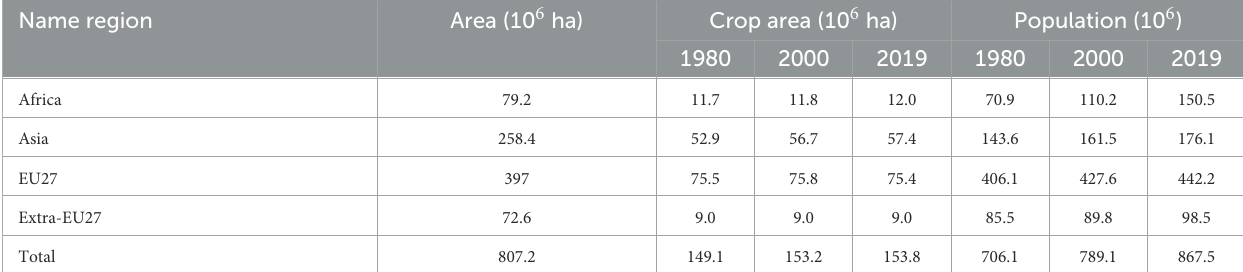
TABLE 2 Description of the study area by